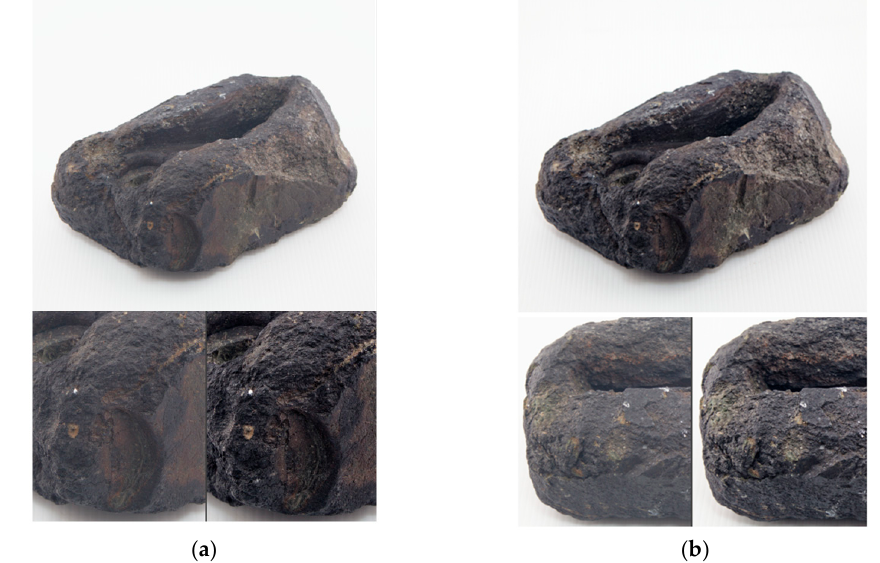
Figure 4. Example of images captured for the find S1: ( a ) Original images; ( b ) Enhanced images with corrections. Quality improvement was achieved by adjusting RAW white balance, color correction, noise reduction and exposure compensation parameters.